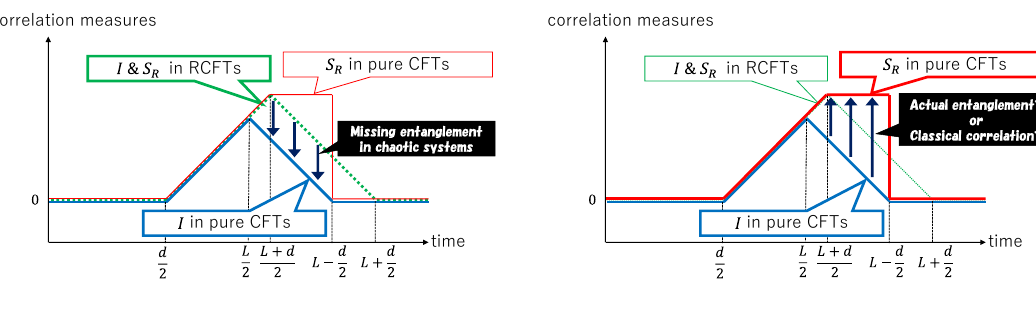
Figure 2 . Left: the comparison of the mutual information in integrable systems (RCFTs) and chaotic systems (pure CFTs). The growth in RCFTs can be captured by the quasi-particle picture (see (cid:12)gure 1). However, the growth in pure CFTs shows the breakdown of the quasi-particle picture. It seems that the entanglement is missing in chaotic systems. Right: the comparison between the mutual information ( I ) and the re(cid:13)ected entropy ( S R ). We (cid:12)nd a remarkable discrepancy between these two measures in chaotic